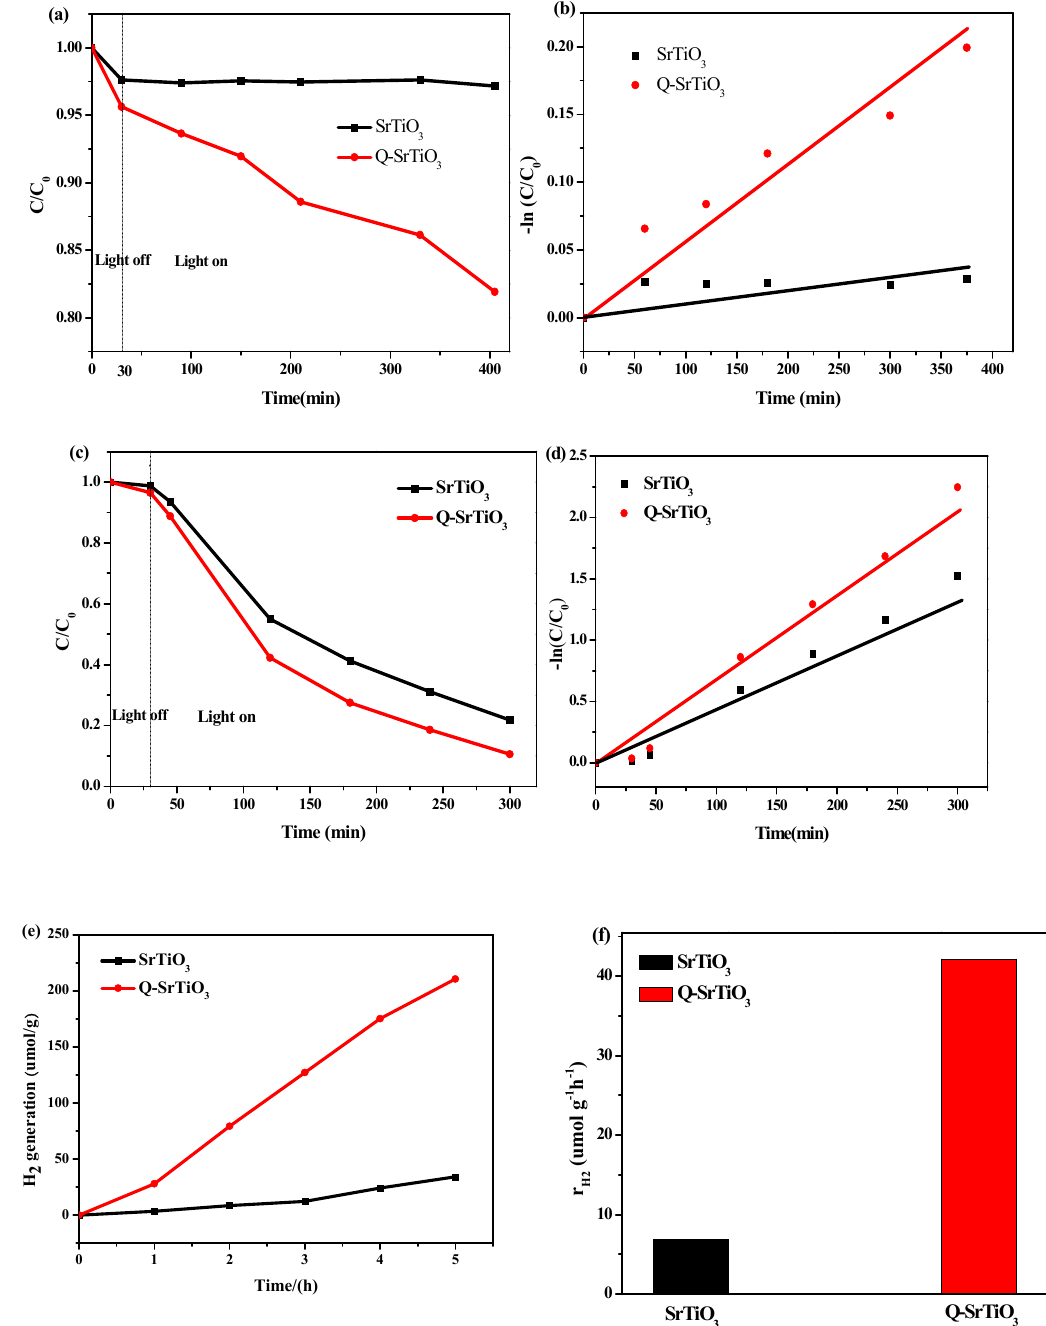
Figure 5. Photodecomposition of RhB aqueous solution with SrTiO 3 and Q-SrTiO 3 under visible light ( a ) and UV light ( c ). − ln ( C / C 0 ) of the RhB concentration as a function of visible light ( b ) or UV light ( d ) irradiation time. Time-course of photocatalytic water splitting for H 2 generation in 100 mL 10% aqueous methanol solution under solar light ( e ). The rate of hydrogen generation for SrTiO 3 and Q-SrTiO 3 under solar light ( f ).